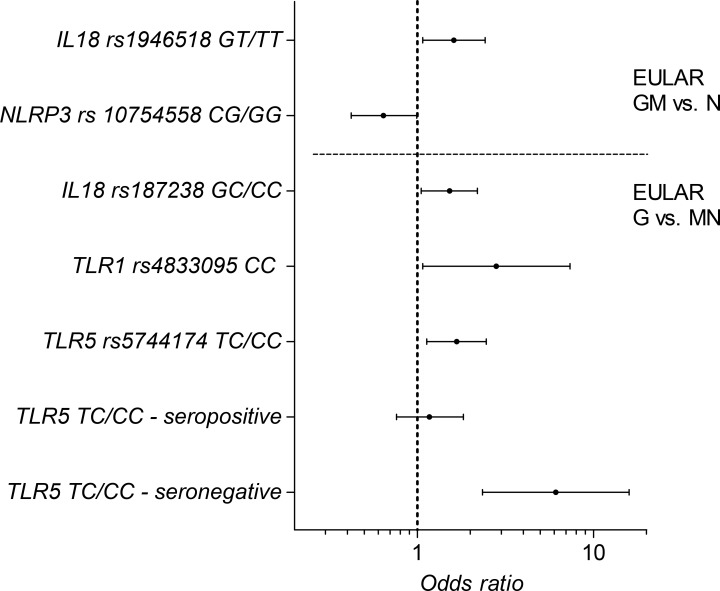
Odds ratio for association between polymorphisms in IL18, NLRP3, TLR1 and TLR5 and EULAR good/moderate vs. none and good vs. moderate/non-response, respectively.For TLR5 rs5744174, patients were also stratified on diagnosis based on IgM-RF (seropositive-/seronegative RA). Log scale, 95% confidence interval.